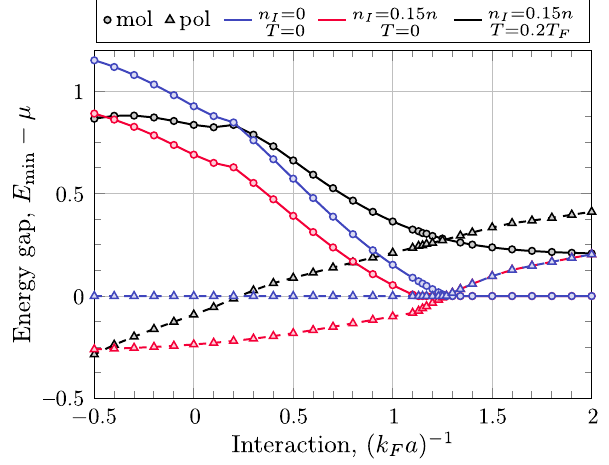
13. Polaronic and molecular energy gap. Energy gap between the lowest-lying polaron and molecule modes and the chemical potential versus interaction strength. The blue lines show the gap for the case of a single impurity at T ¼ 0 , while the red and black lines show the gaps for finite density at T ¼ 0 and T > 0 , respectively. The solid lines with circle markers denote the gap between the lowest-lying molecular state and the chemical potential, whereas the dashed lines with triangle markers denote the polaronic